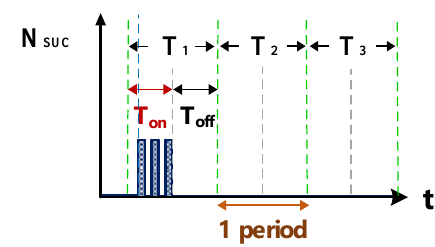
Figure 7. Counter waveform of discharge success rate.